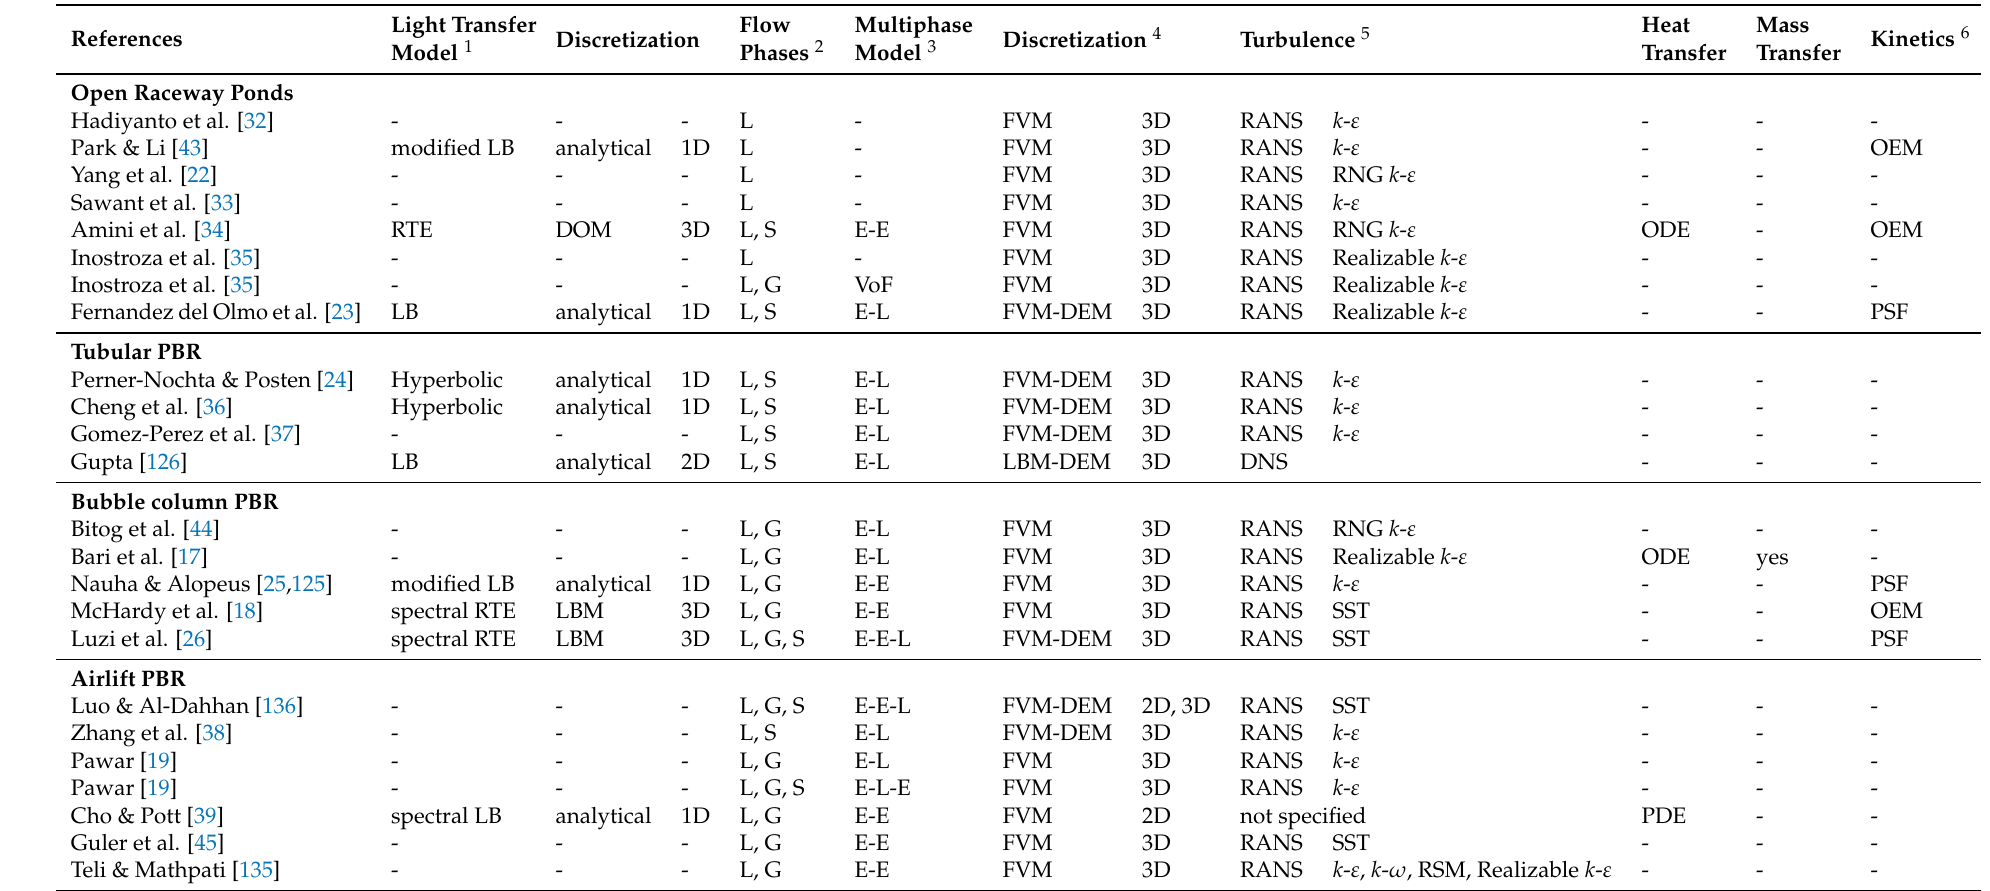
Table 1. Overview of photobioreactor (PBR) models. Abbreviations are explained at the table